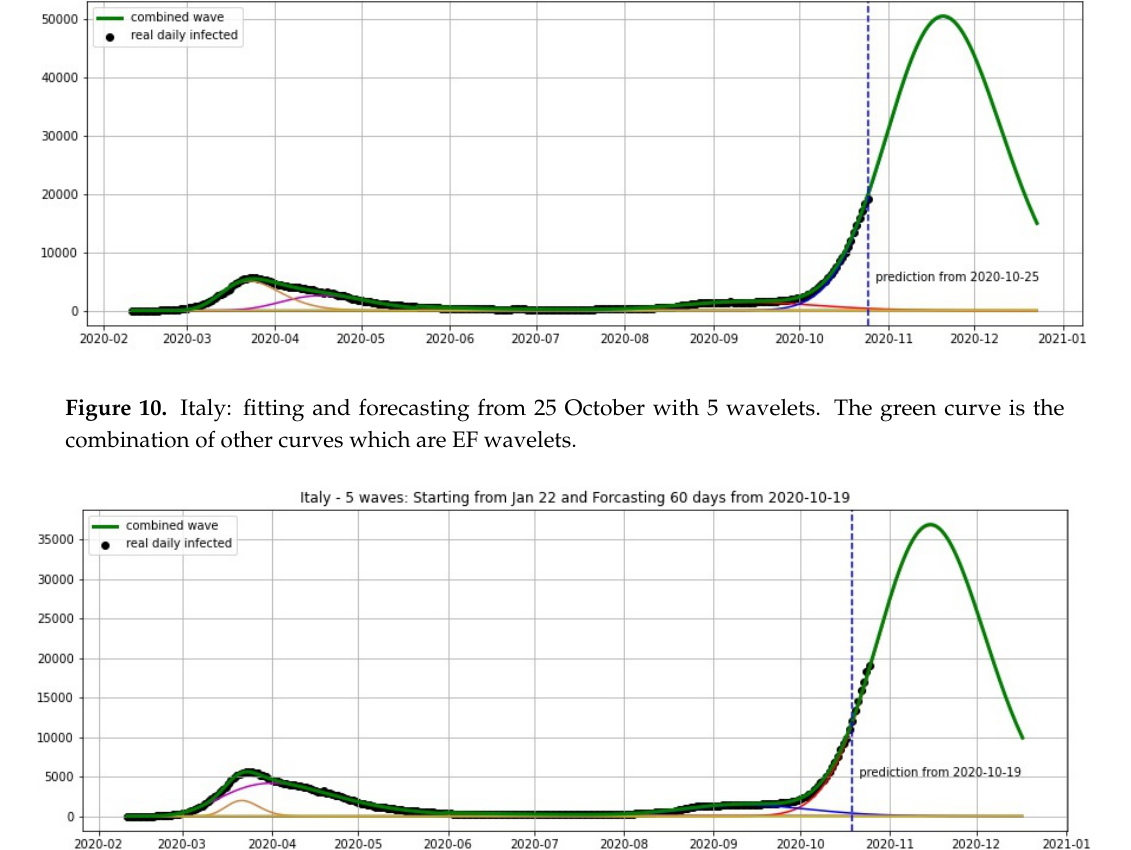
Figure 11. Italy: fitting and forecasting from 19 October with 5 wavelets. The green curve is the combination of other curves which are EF